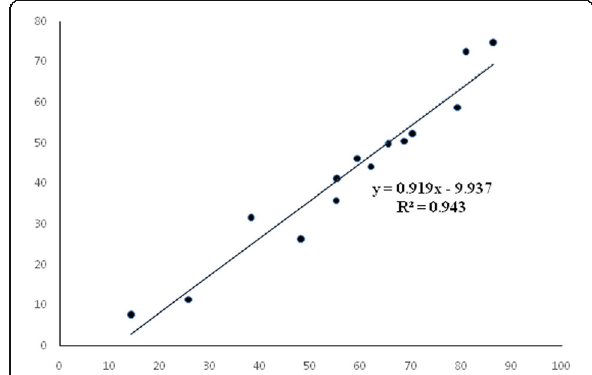
Fig. 1 Graph representing correlation of Total Phenolic Content and Total Flavonoid Content in terms of ( μ g GAE/mg) and ( μ g QE/mg)